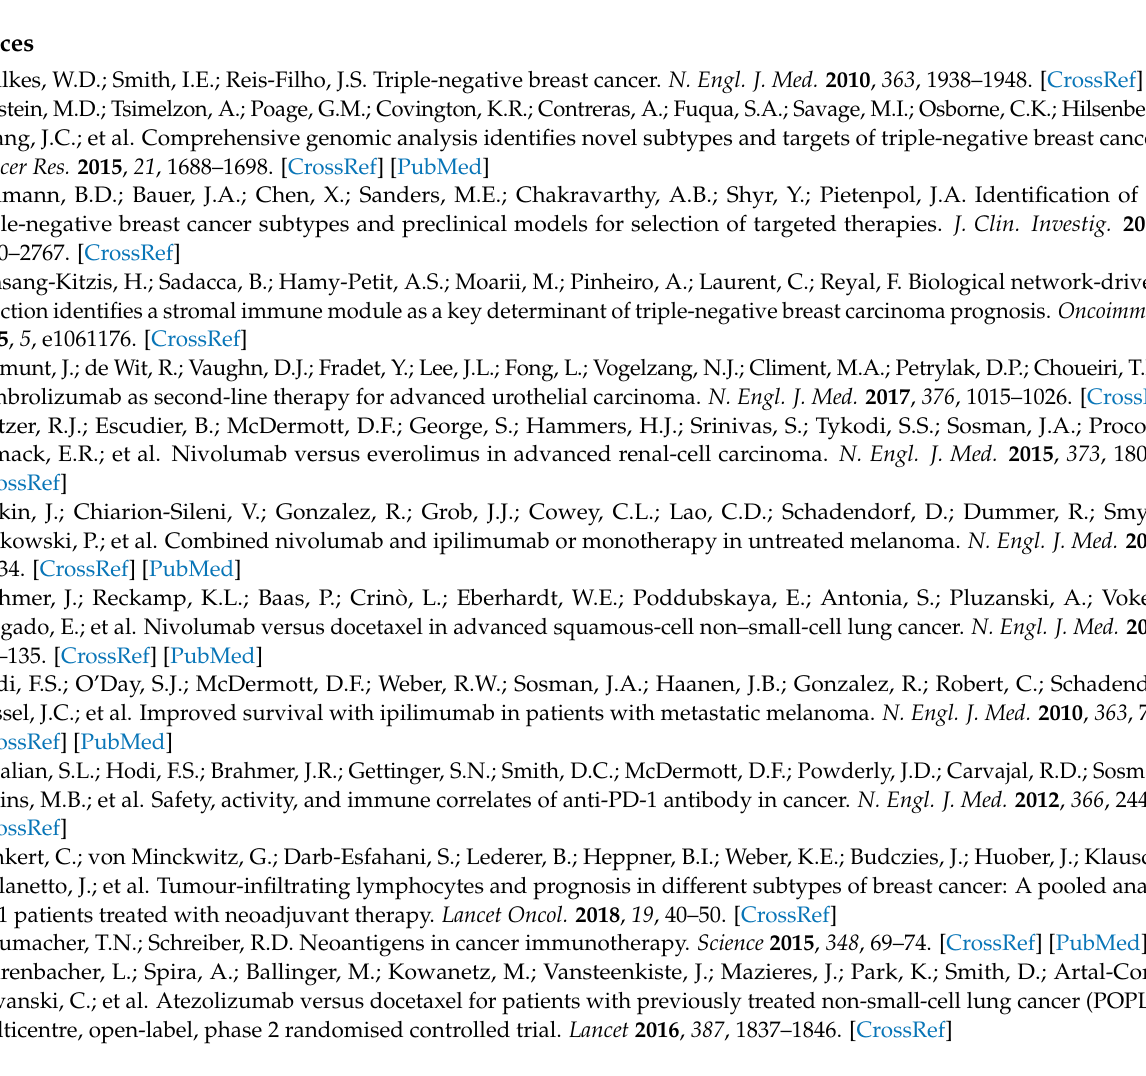
of 67 immune-related hub DEGs. Table S5: DEGs in different IRGPI groups. Table S6: CIBERSORT results. Table S7: TIDE